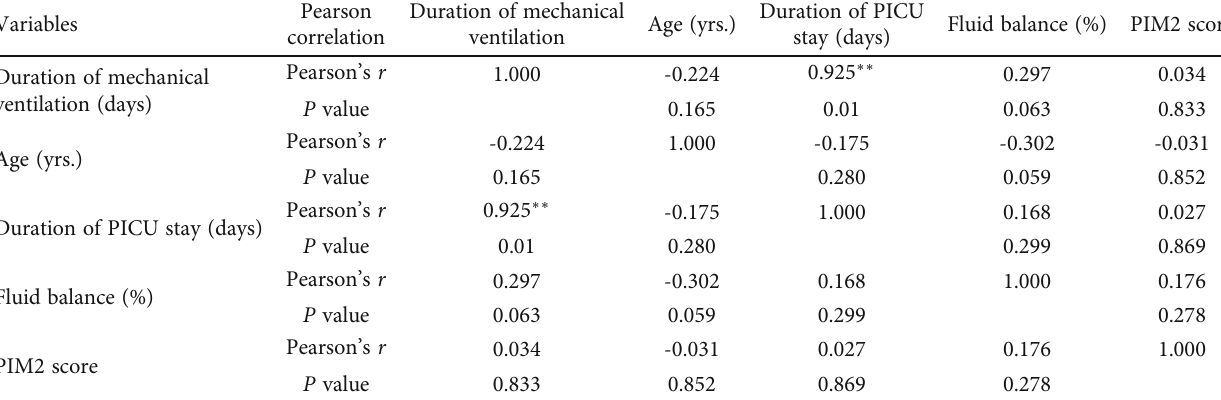
Table 4: Correlation between duration of mechanical ventilation (days) and various other variables.